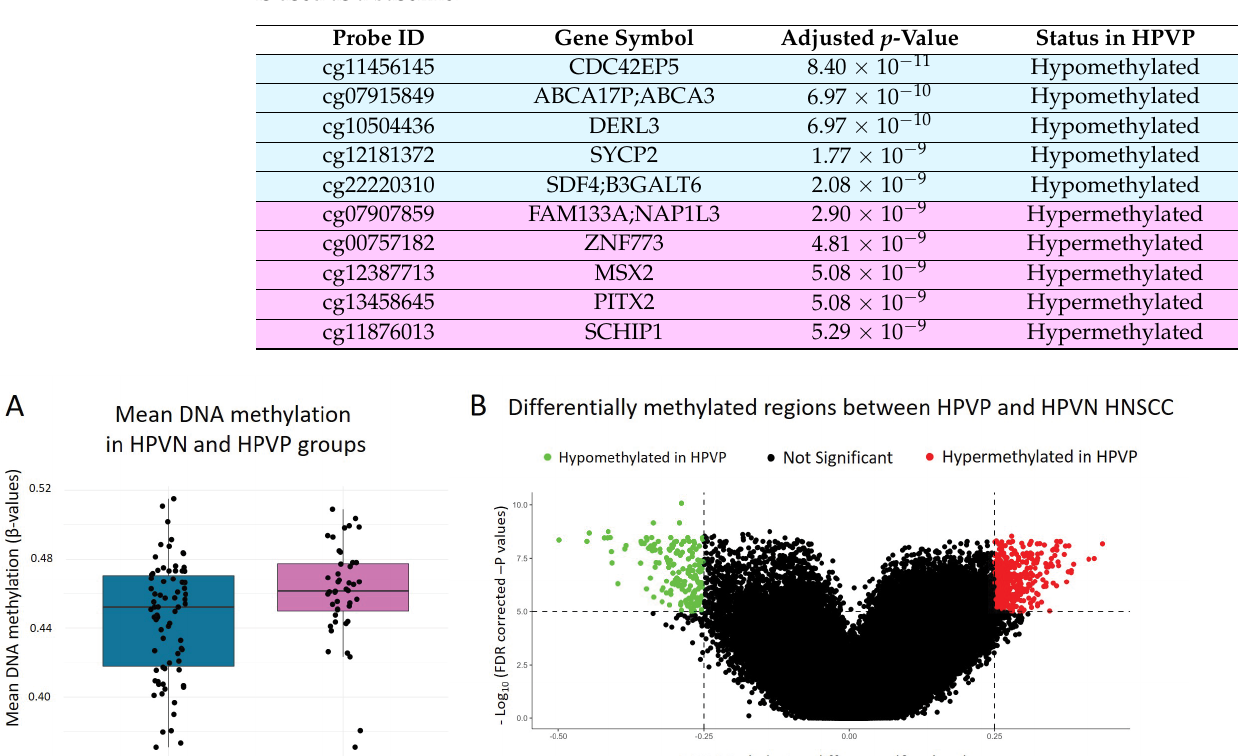
Table 5. Top 5 hypo- and hypermethylated genes among HPVN and HPVP HNSCC patients. HPVN is used as a baseline.